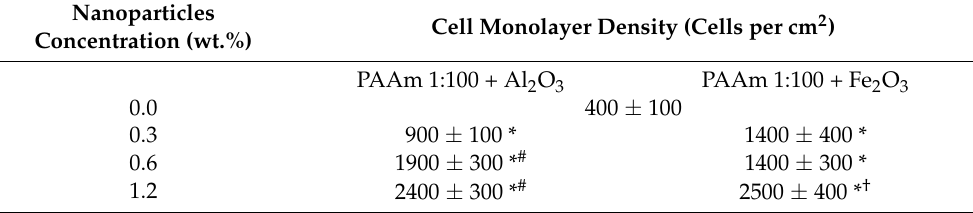
Table 2. Proliferation of fibroblasts on the surface of PAAm gels with different concentrations of Fe 2 O 3 or Al 2 O 3